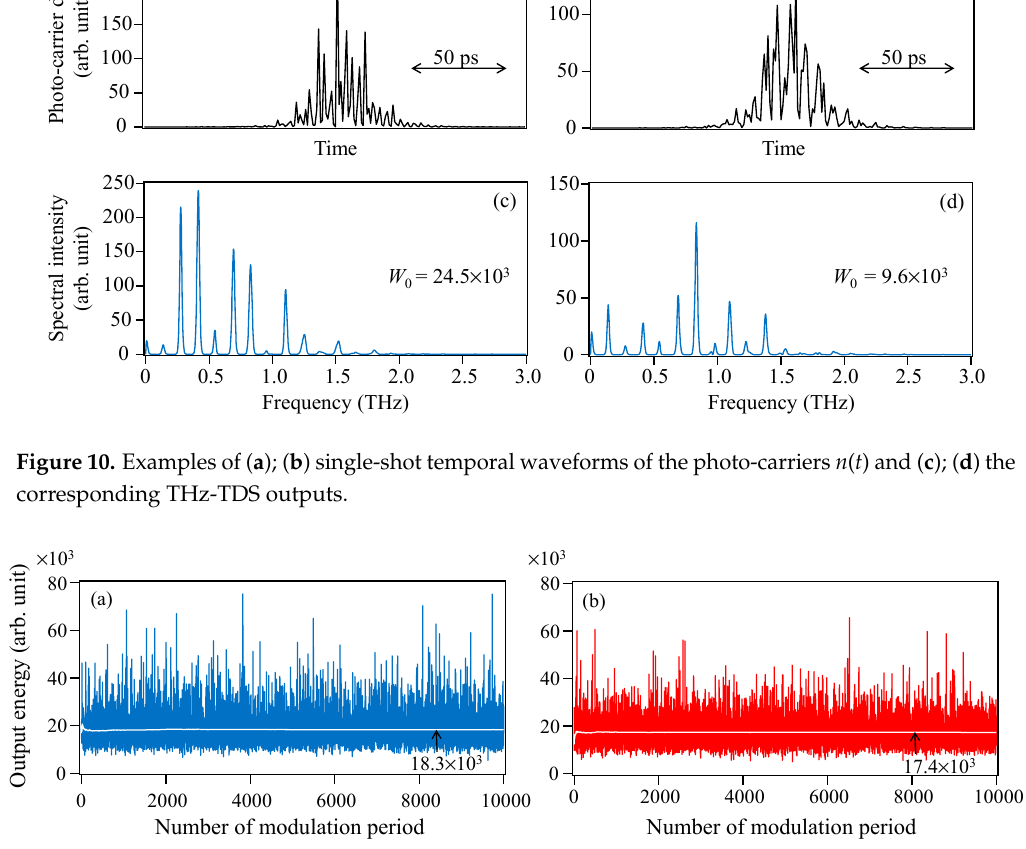
Figure 11. Temporal variations in the THz-TDS outputs from 0 to 10,000 times the modulation period when Langevin noise is ( a ) excluded and ( b ) included. The averaged THz-TDS outputs are indicated by white lines.